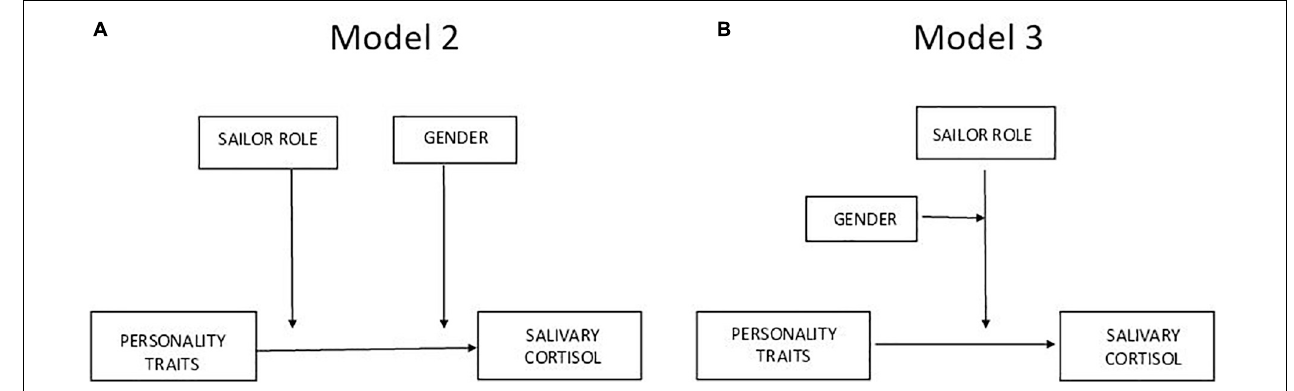
FIGURE 1 | Moderated analyses computed using both moderators, simultaneously (A) and the moderated moderation (B) .